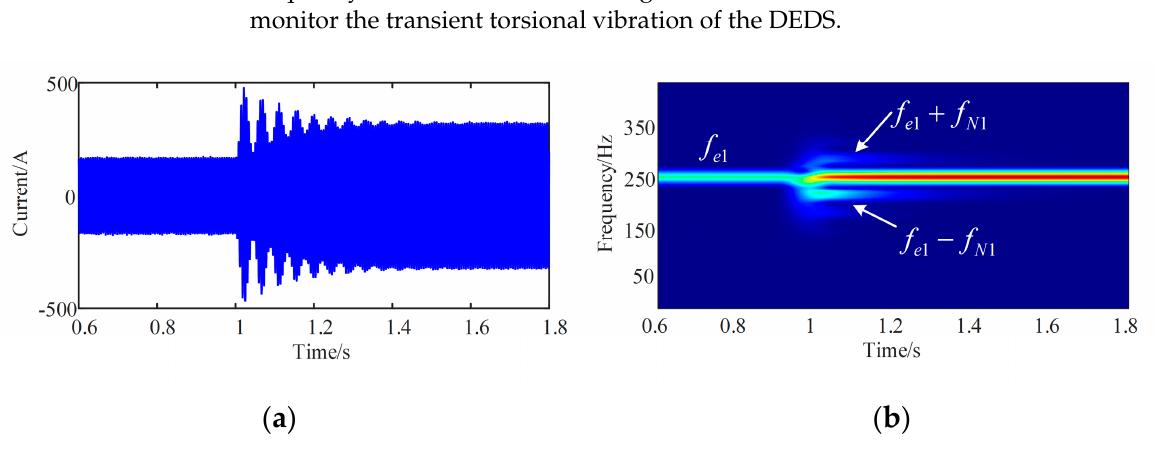
Figure 17. The meshing force of the first gear pair: ( a ) time domain; ( b ) time-frequency domain (0- 80 Hz). Figure 18 shows the response of the motor stator current during the impact process. After the DEDS suffers from the impact load, side frequencies of the form | f e 1 ± f N 1 | appear on both sides of the power supply frequency with the system’s first-order natural frequency as the interval, indicating that the motor stator current has a certain ability to monitor the transient torsional vibration of the DEDS.